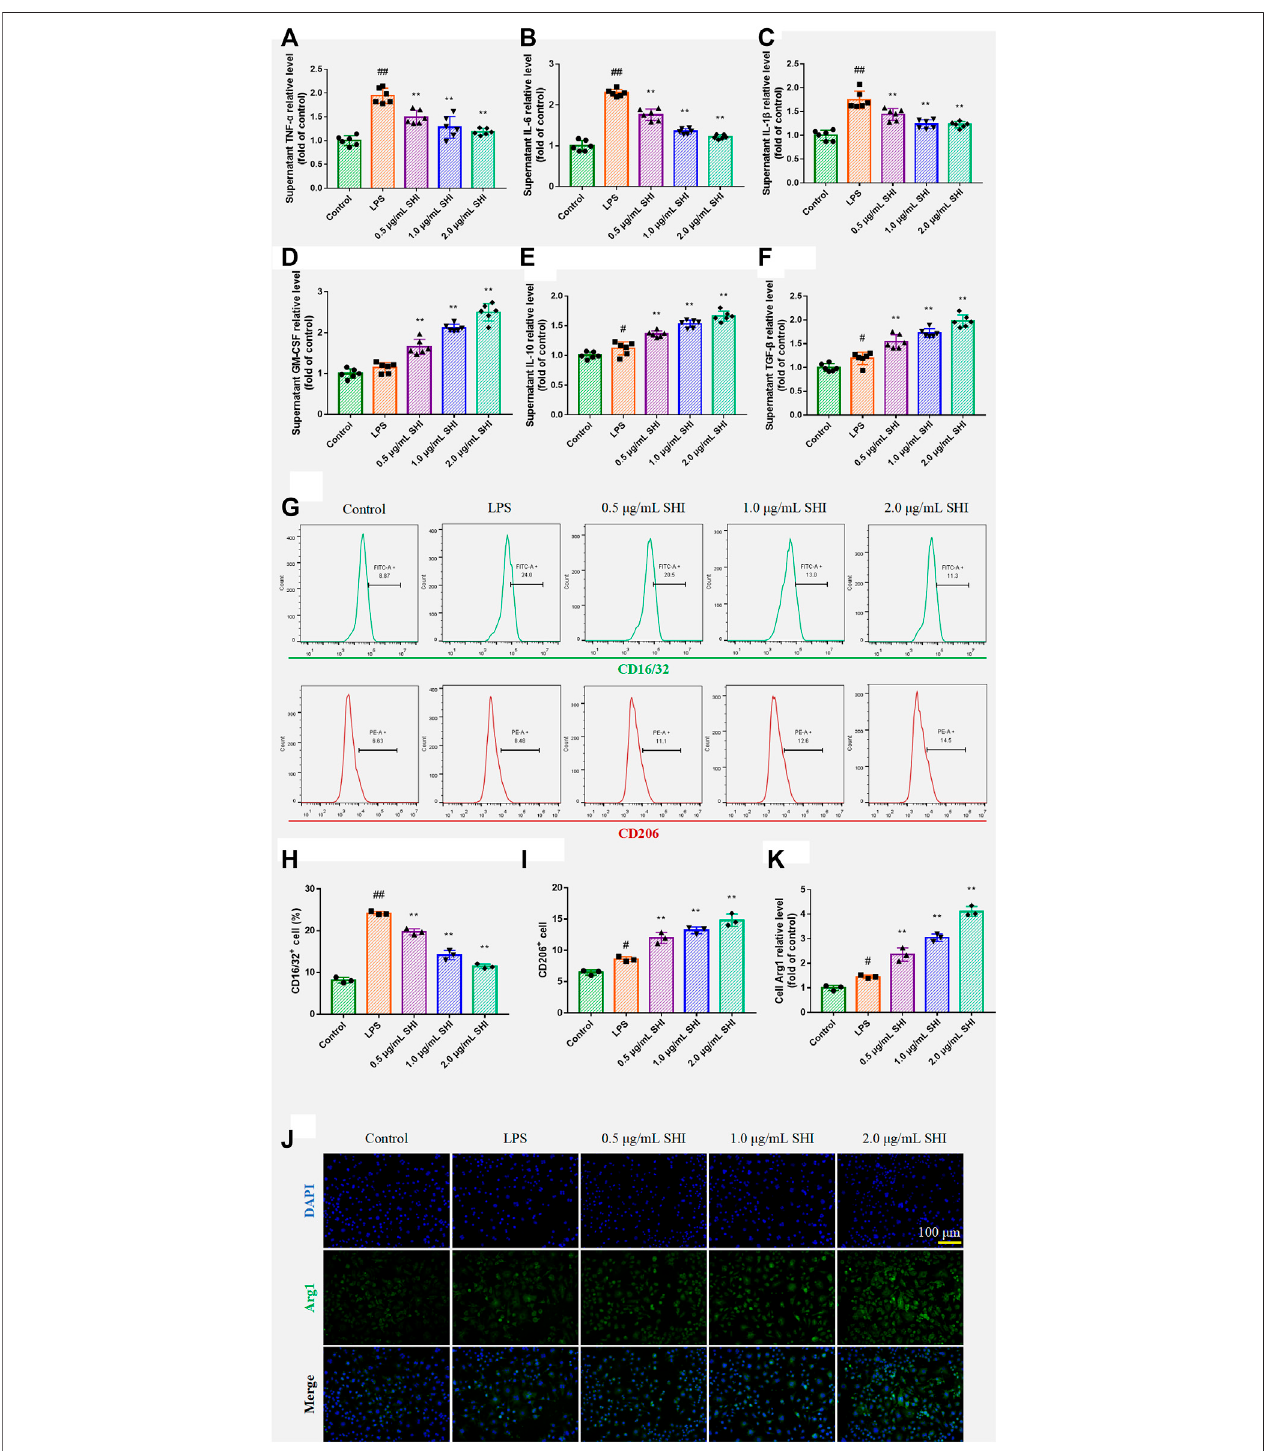
FIGURE 3 | The effect of SHI on macrophage polarization in LPS-induced RAW264.7 cells. The cells were treated with SHI (0.5, 1.0, and 2.0 μ g/ml). About 2 h later,thecellswerestimulatedwithLPS(5 μ g/ml)for24 h.Therelativelevelsof (A) TNF- α , (B) IL-6, (C) IL-1 β , (D) GM-CSF, (E) IL-10,and (F) TGF- β inthesupernatantof LPS-induced RAW264.7 cells. (G – I) The cell count of CD16/32 and CD206. (J,K) The ECM1 expression by immuno fl uorescence. The data are expressed as mean ± SD. Compared with control: # p < 0.05, ## p < 0.01. Compared with LPS: * p < 0.05, ** p < 0.01.